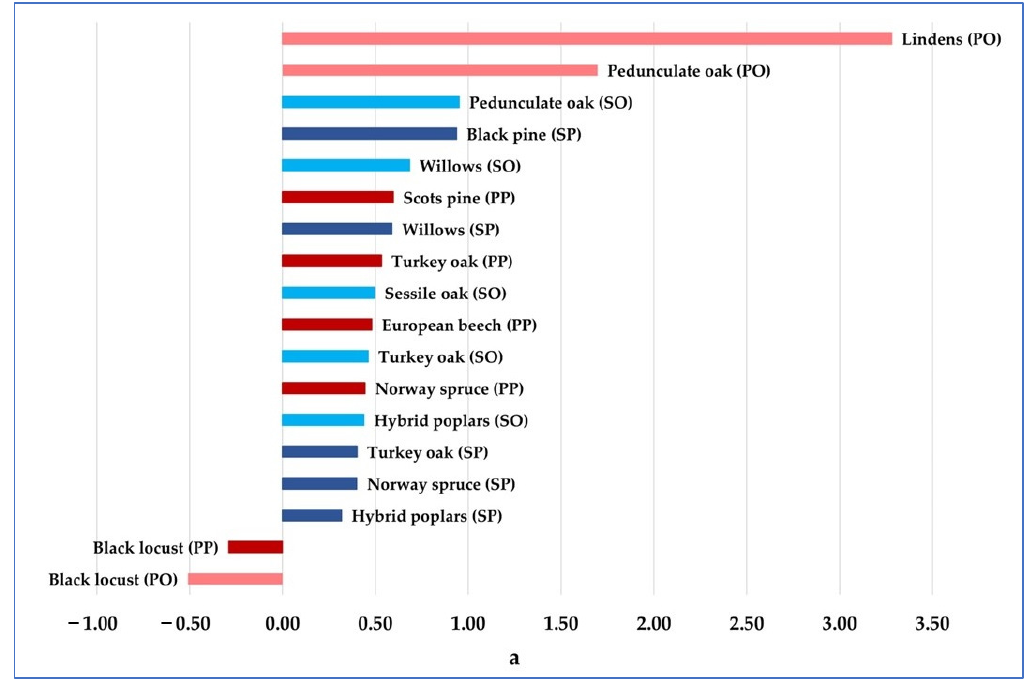
Figure 3. Values of the regression slope (parameter ‘a’) of the trendline of harvesting ages (where R 2 > 0.5) weighted by the area under harvest sorted in descending order and colored by management purpose and ownership. Negative ‘a’ values mean decreasing trend while positive values mean increasing trend. (SP: state-owned production forests; SO: state-owned forests with other management purpose; PP: private production forests; PO: private forests with other management